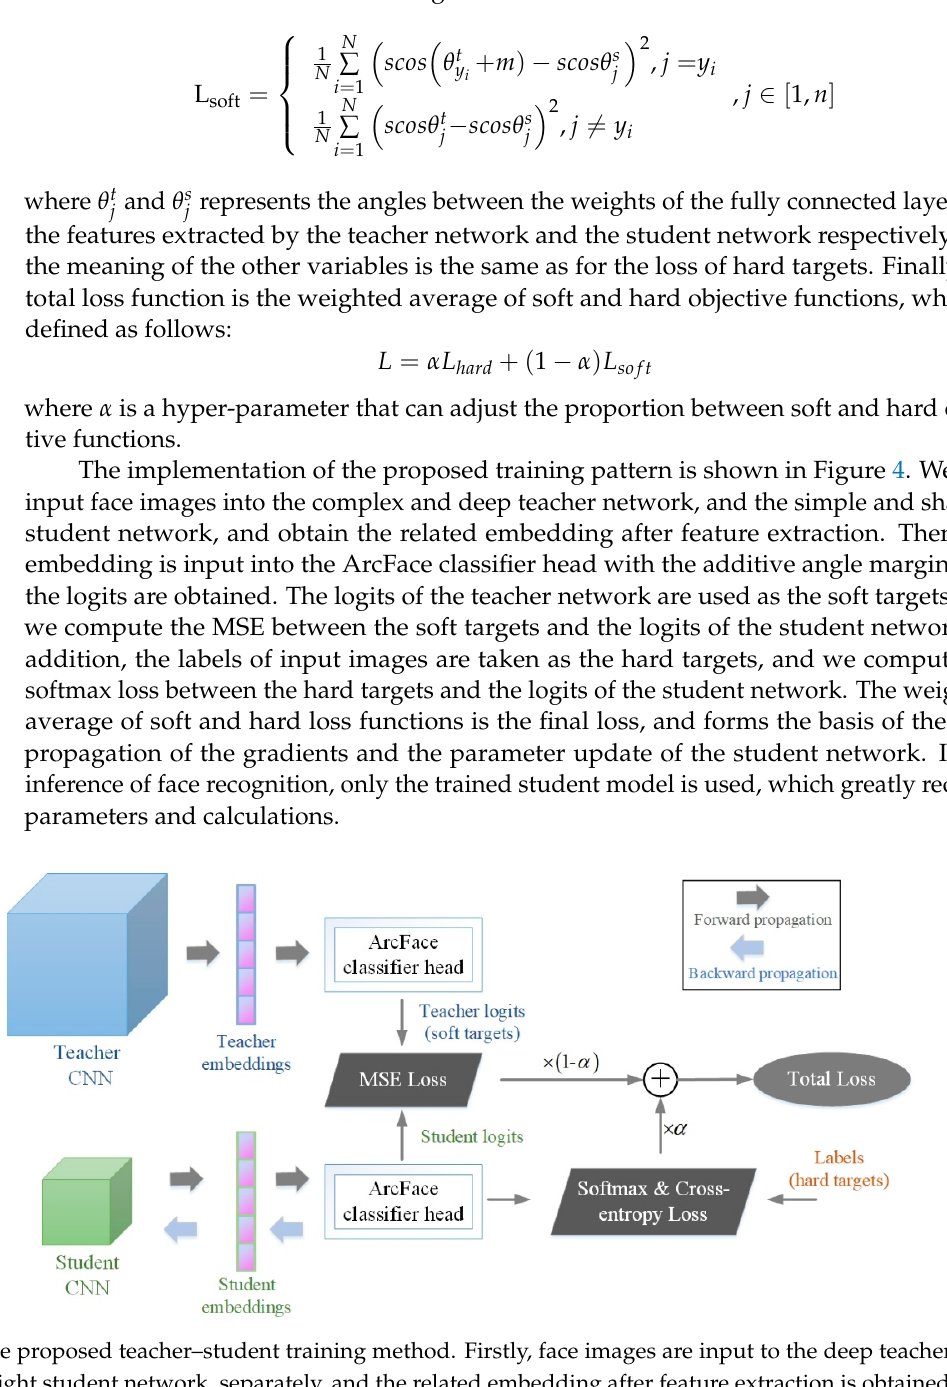
Figure 5. The structure of the IR unit and SE-IR block. The left IR unit means the improved resid- ual unit, and the right SE-IR represents the improved residual unit combined with the SE block. 4. Experiments and Analysis In this section, we first introduce the datasets, evaluation metric, and the details of the training settings, then describe the performance of the baseline model, and compare and analyze the experimental results of the proposed methods.